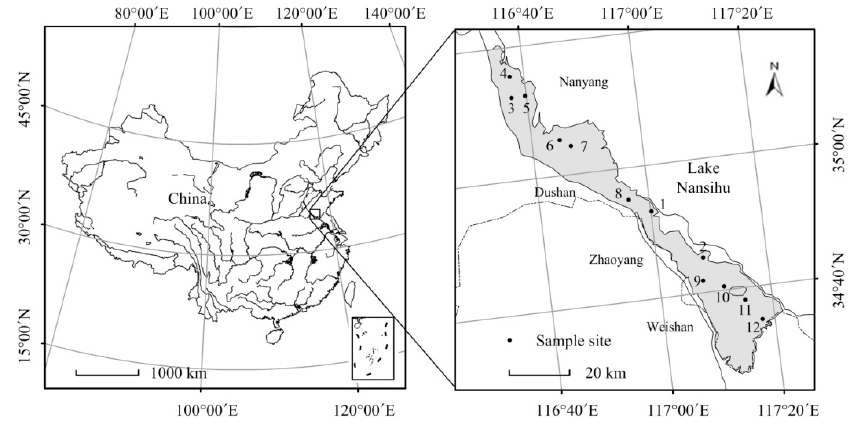
Figure 1. Location of Lake Nansihu and the sample sites in the lake. This figure was generated using ArcGIS Version 10.0 (ESRI, Redlands, CA, USA).